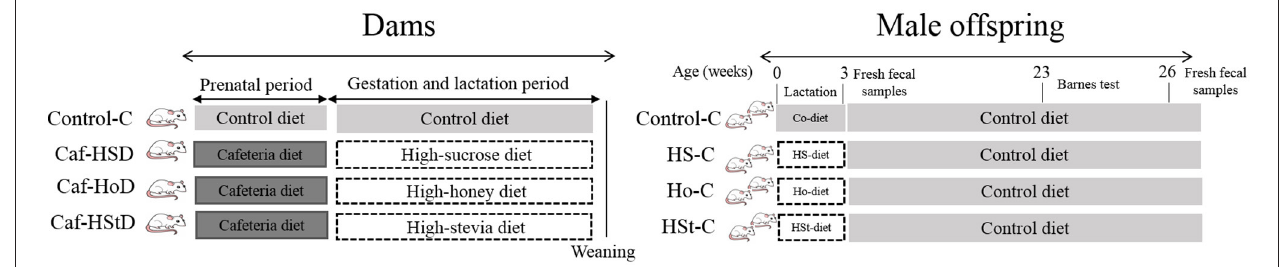
FIGURE 1 | Experimental